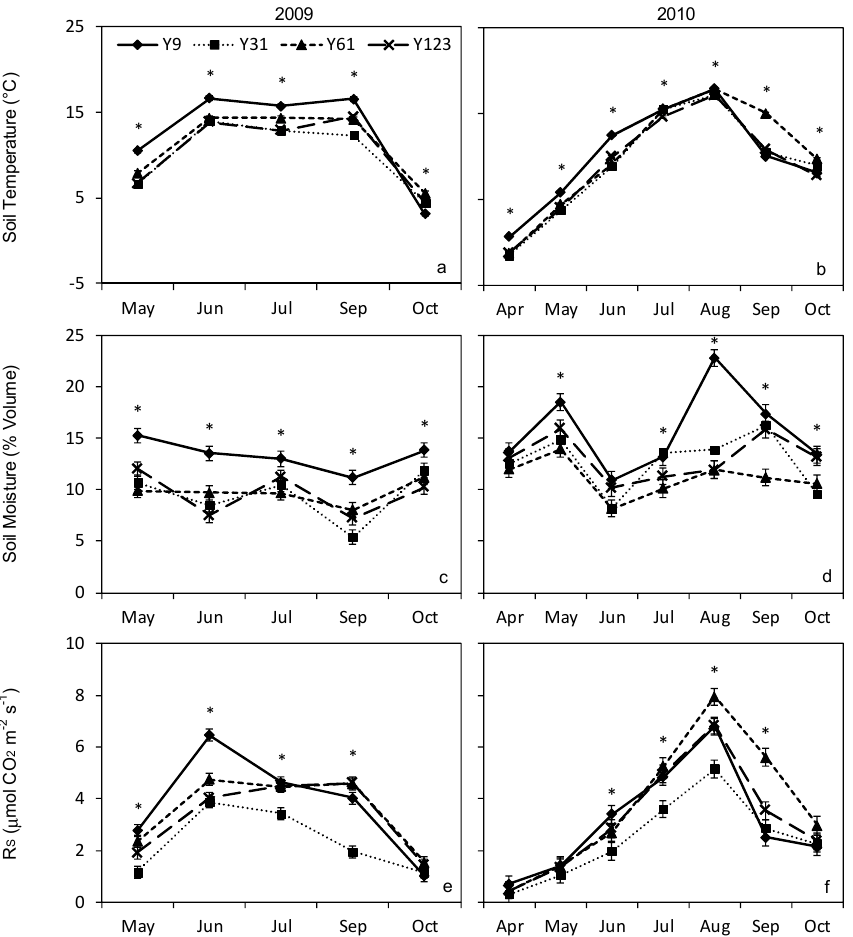
Figure 1. Soil temperatures (a, b), soil moisture (c, d), and soil respiration (R S , e, f) from two years of measurement in 9, 31, 61, and 123 year-old red pine stands in northern Minnesota, USA. Error bars indicate standard error. An asterisk indicates a month with significant differences among stand ages.